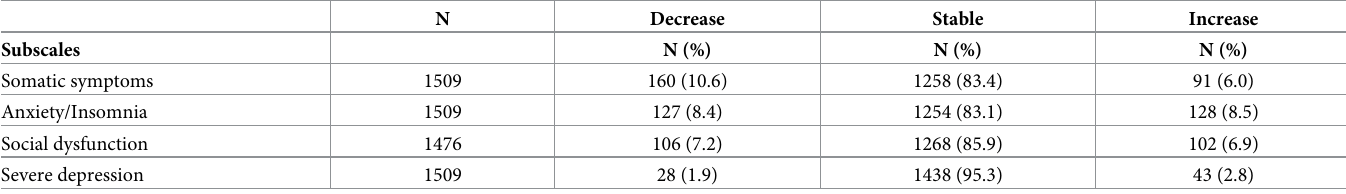
Table 2. Changes in GHQ-28 subscales over the first lockdown